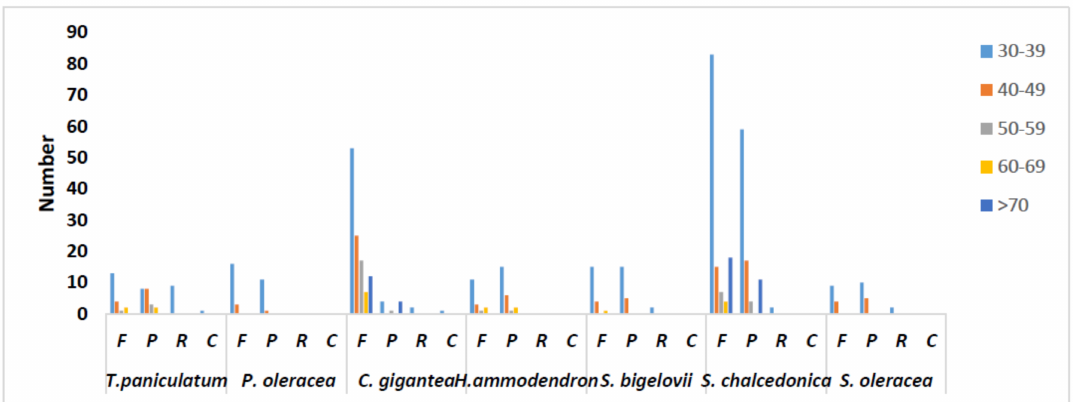
Figure 2. Repeat sequences in seven chloroplast genomes of Caryophyllales. REPuter was used